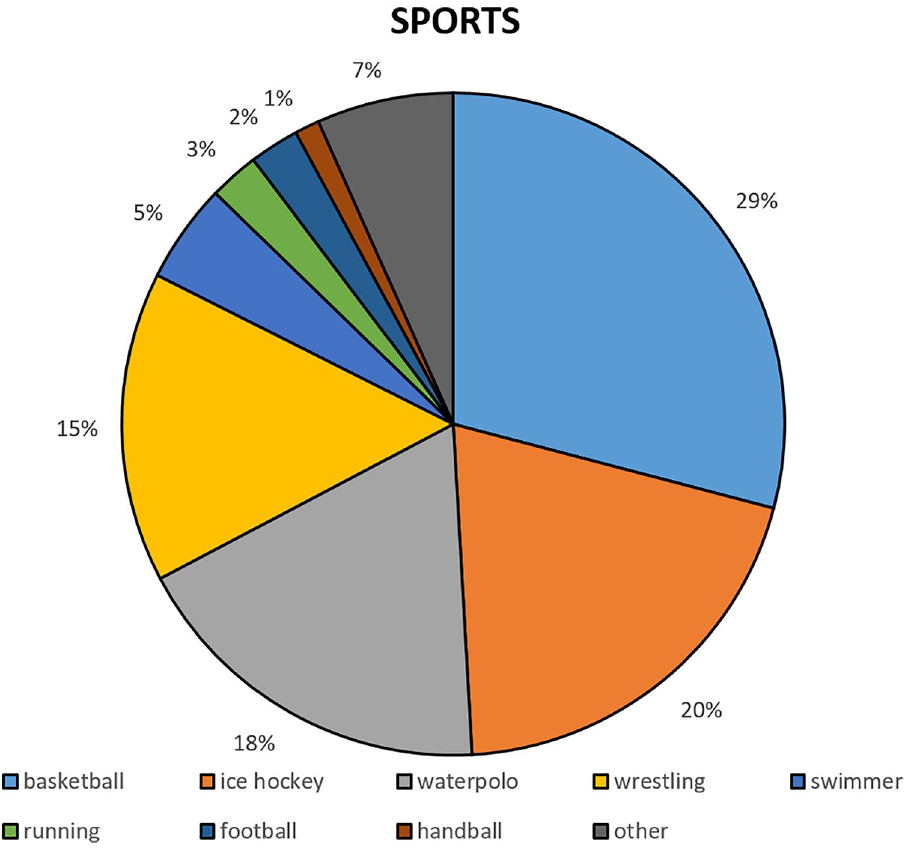
Figure 1. Types of sports of the examined asymptomatic elite